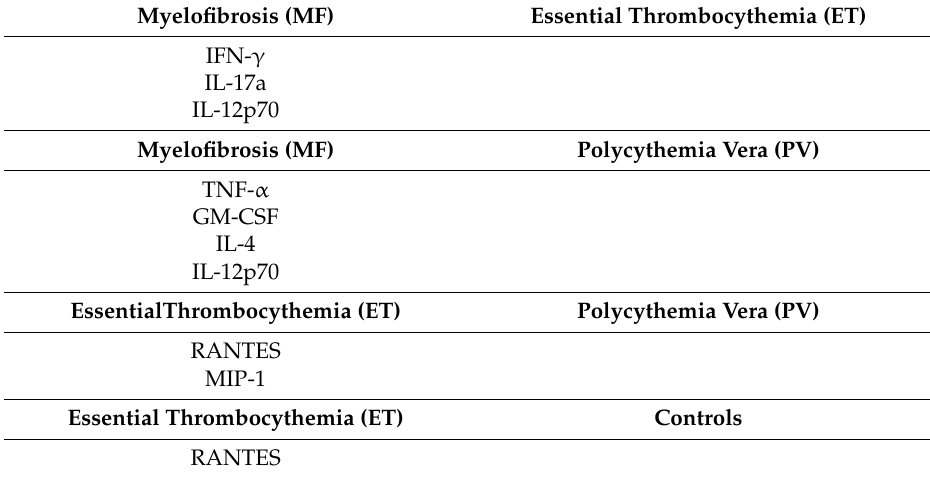
Table 1. Overall one-to-one comparison of cytokine / chemokine balance between: (i) MF and ET; (ii) MF and PV; (iii) ET and PV; and (iv) ET and controls. Each of the four comparisons highlights the cytokines / chemokines displaying higher concentration in one condition with respect to the other (i.e., to which the comparison is